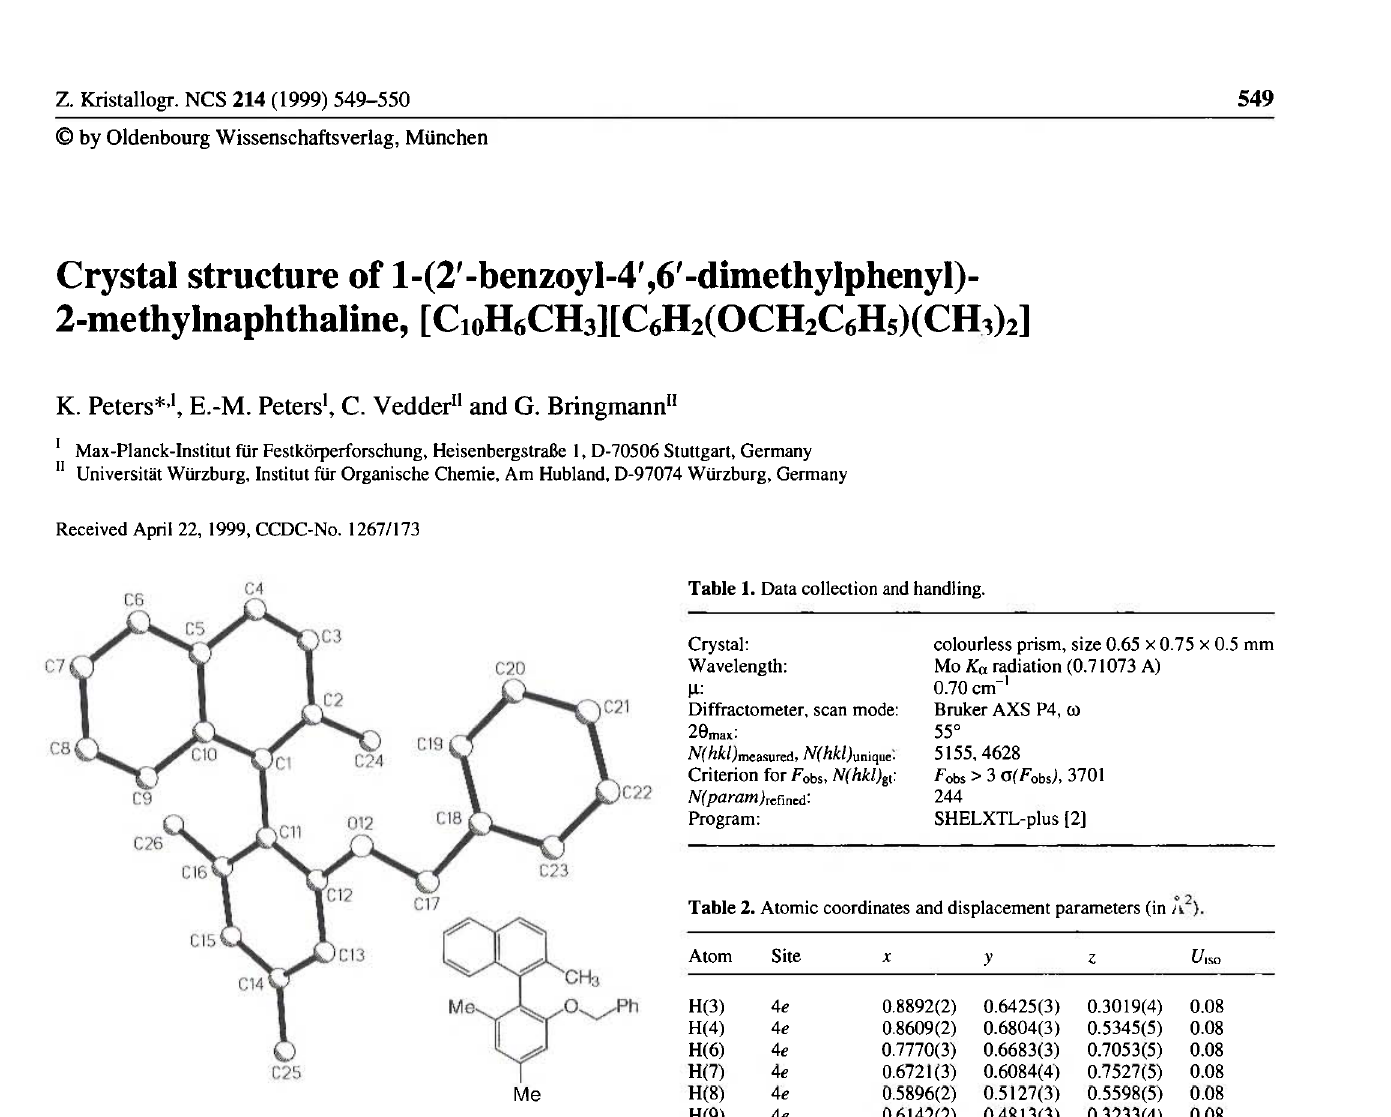
Table 2. Atomic coordinates and displacement parameters (in 1